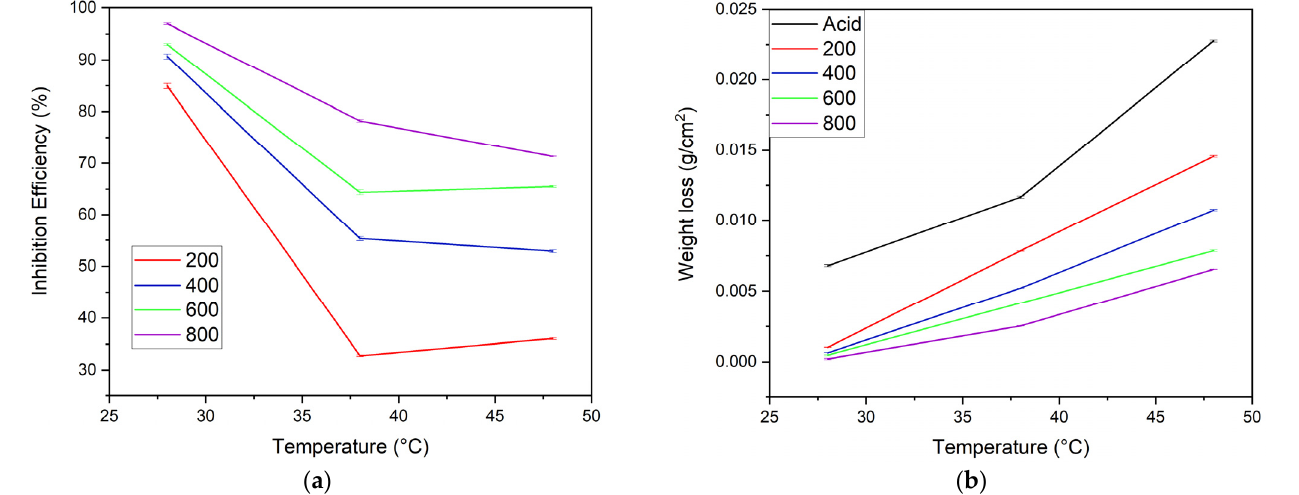
Figure 7. Effect of temperature ( a ) on the IE of different concentrations of inhibitor and ( b ) on the weight loss of MS samples in acid and different inhibitor solutions ( n = 3 for each assay).